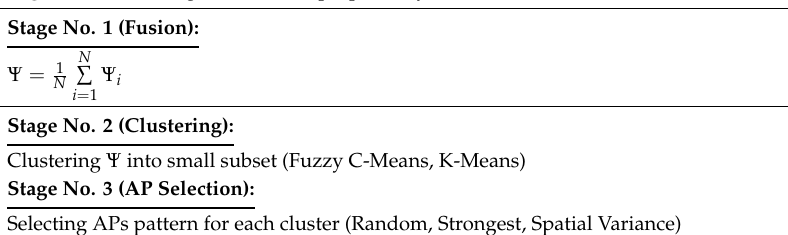
Algorithm 2. The algorithm of the proposed system.